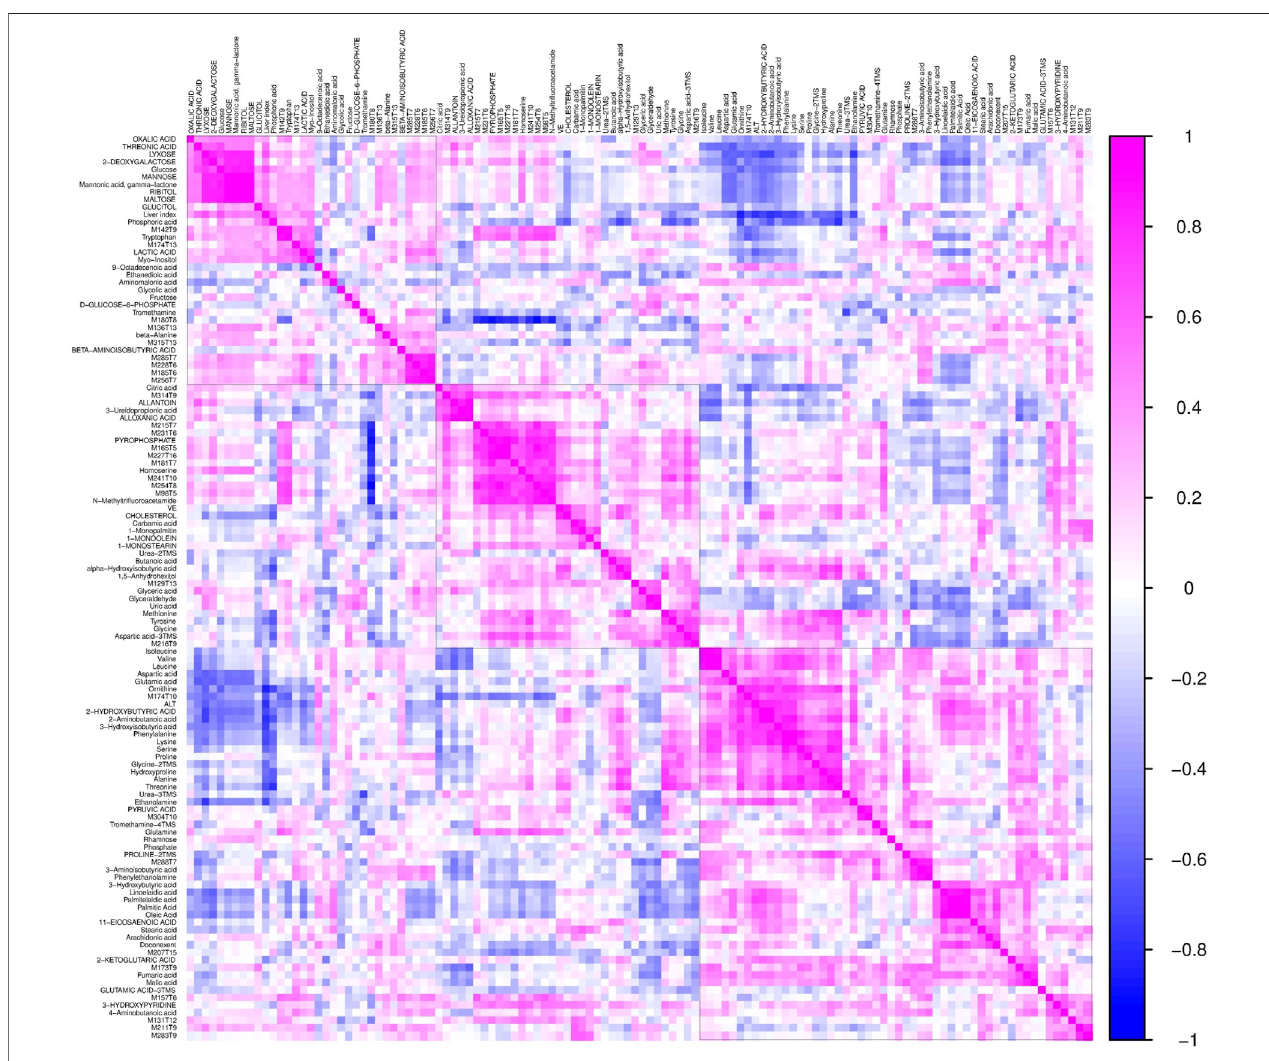
FIGURE 6 | The heatmap shows the correlation coef fi cients between the liver index and individual metabolites. Each square represents the Pearson ’ s correlation coef fi cient between the metabolite of the row and the column. Magenta color represents a positive correlation and blue color represents a negative correlation.